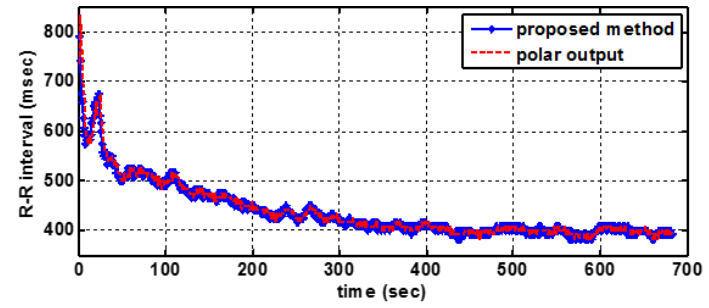
Figure 16. The algorithm implementation in a wearable heart rate sensor .